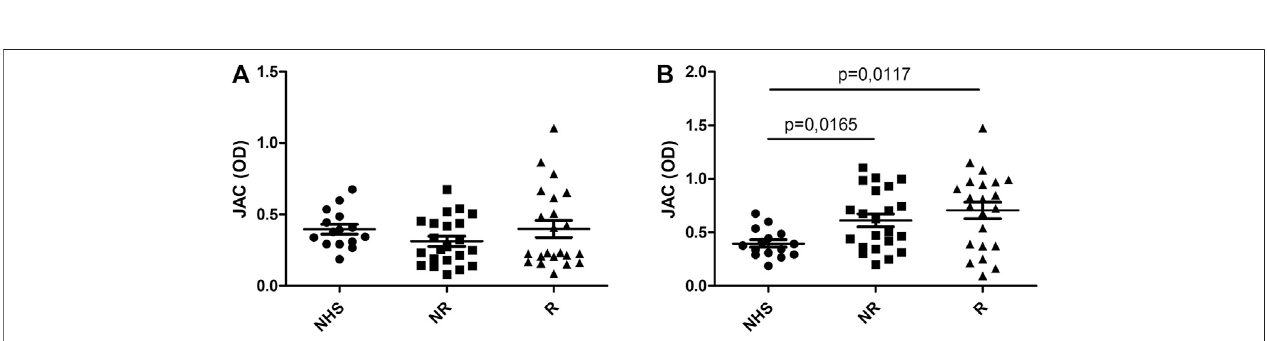
FIGURE2| JACaf fi nityforIgGcomplexinUlcerativeColitiscomparedtohealthysubjects(NHS).Lectin-basedELISAcoatedwithFabantiFabIgG. (A) :atbaseline (T0); (B) : after anti-TNF therapy (T1). NHS (cid:1) healthy subjects, R (cid:1) responders, NR (cid:1) non responders. All values are expressed as Optical Density (OD).